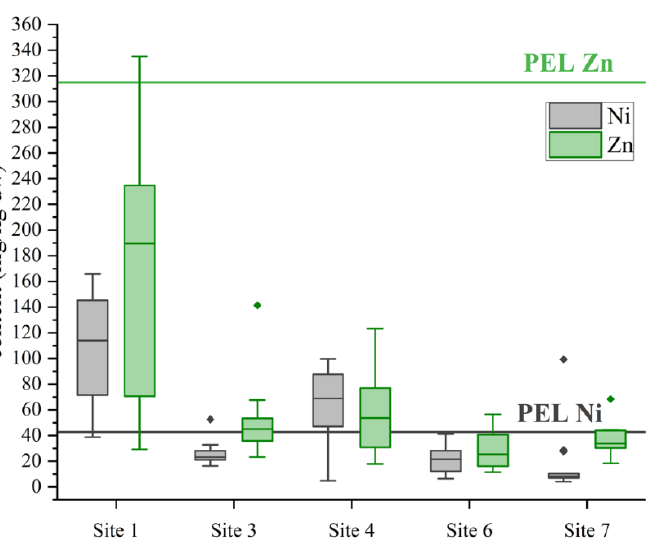
Figure 4. Box plot including probable effect level (PEL) for Ni and Zn indicated with straight lines in sediments from sites along the course of the mining-influenced water.